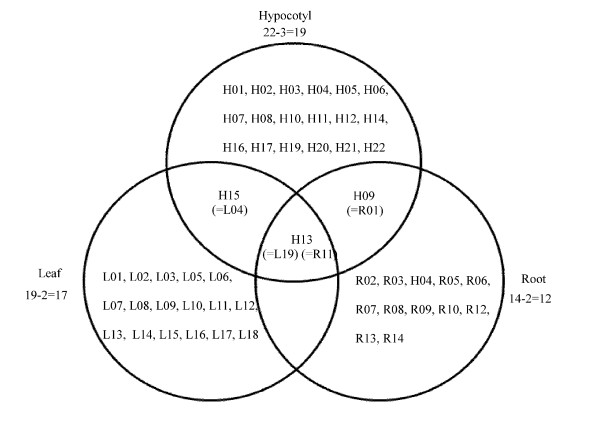
Venn diagram analysis showing up- or down-regulated proteins that overlapped between the leaf, hypocotyl and root of soybean seedlings. Effects of salt stress on these three parts of soybean seedlings were analyzed. Numbers correspond to the protein spots in the 2-DE patterns from the leaf, hypocotyl and root.